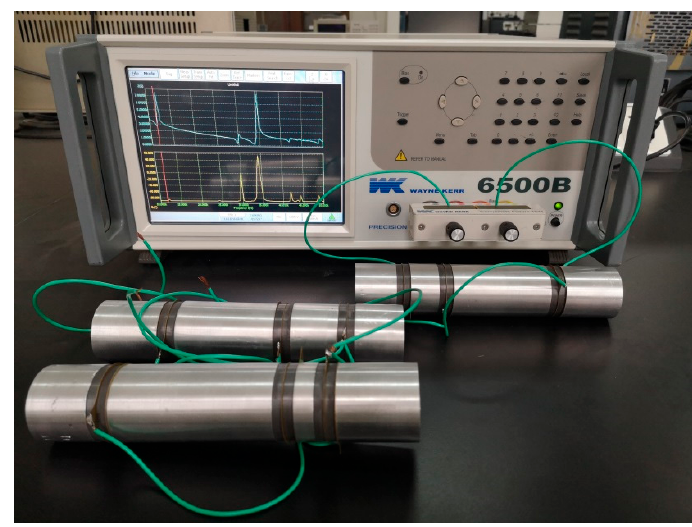
Figure 15. Experimental setup for the measurement of the resonance/anti-resonance frequencies. Sensors 201 9 , 19 , x FOR PEER REVIEW 14 of 17